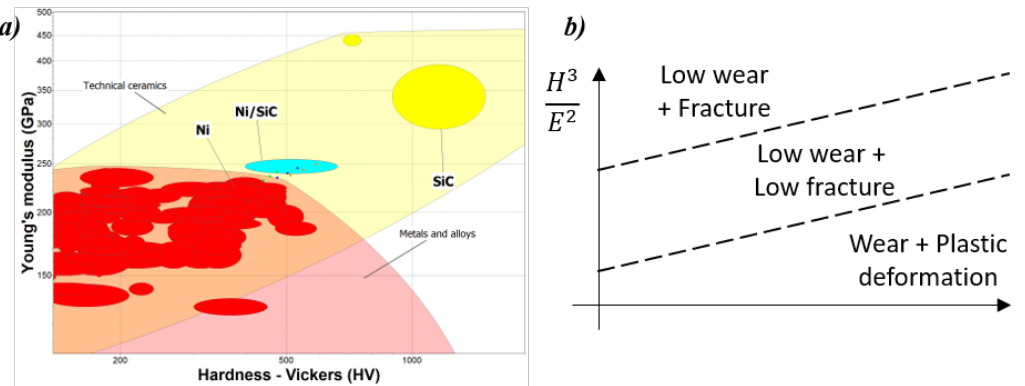
Figure 6. a) Material property map and b) failure mechanism map for PRMMC coating selection.